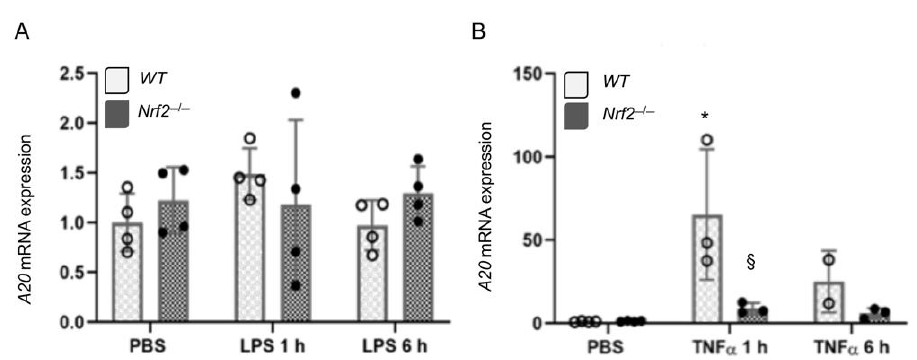
Figure 2. Nrf2 deficiency impairs TNF α stimulated A20 induction in embryonic fibroblasts. Wildtype (WT) MEFS and Nrf2 − / − MEFs were treated with 500 ng/mL LPS ( A ) or 10 ng/mL TNF α ( B ), RNA isolated and A20 mRNA expression analyzed. * versus PBS; § versus WT counterparts. Values of PBS controls are from panel A as TNF α and LPS treatments were carried out in parallel.